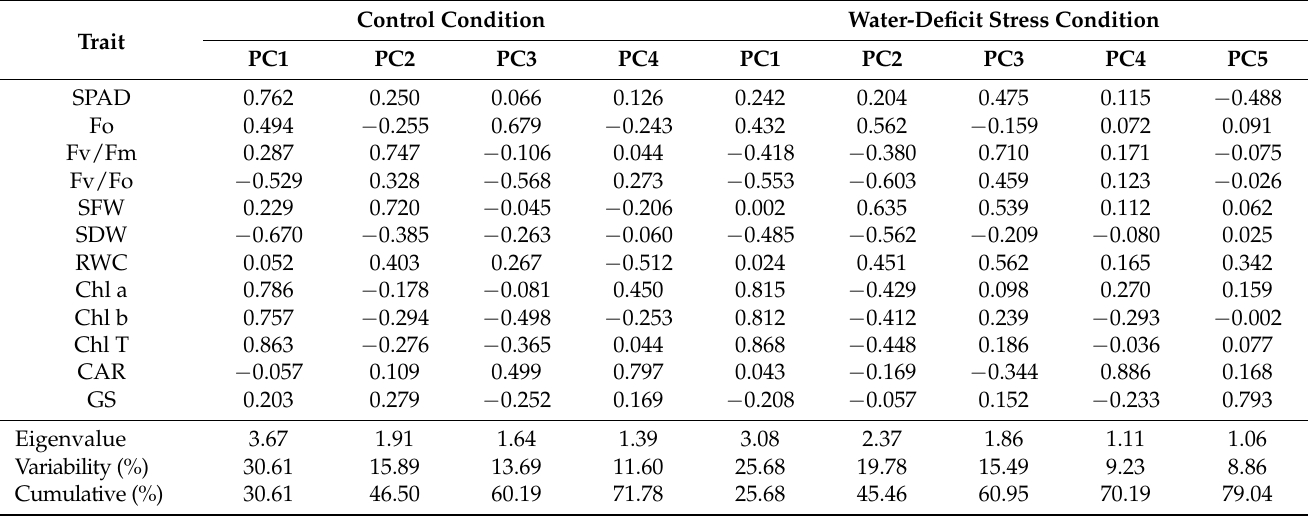
Table 2. The estimated factor loading for the 95 investigated accessions was based on measured physiological and biochemical characters under control and water-deficit stress